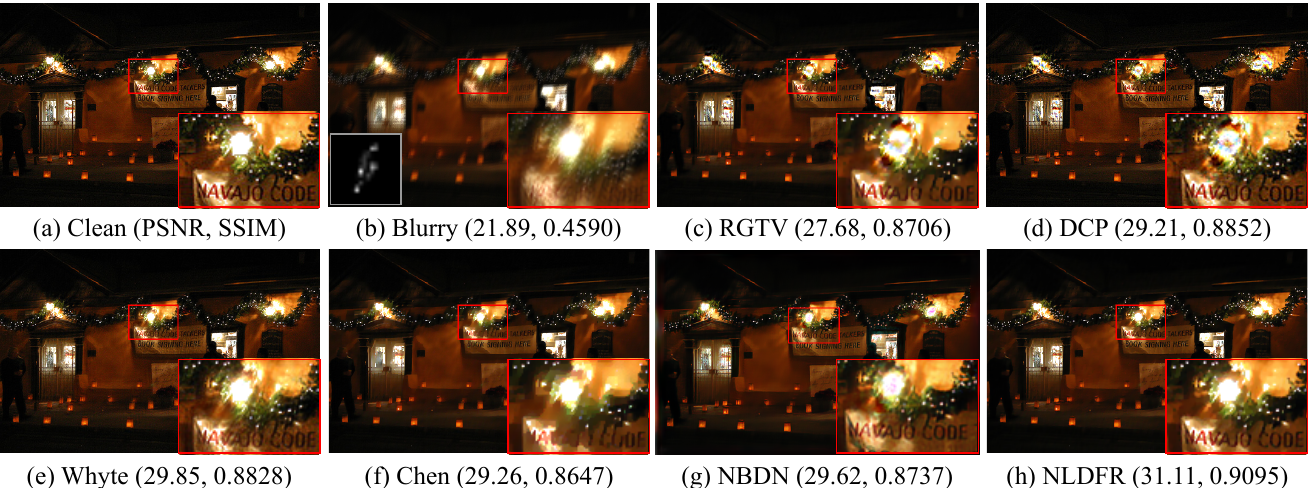
Figure 8. Results of blind deblurring with the estimated kernel. ( a ) Clean image, ( b ) blurry image,